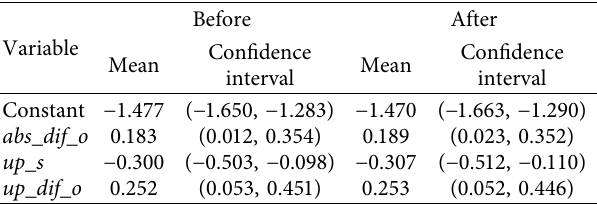
Figure 12: ROC curve and AUC value of the updated low precision data set model. Table 13: SVM classification accuracy.